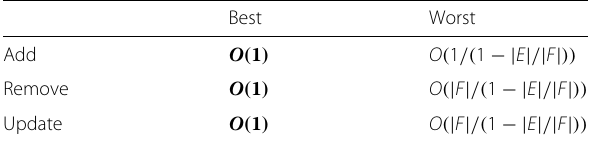
Table 2 Summary of algorithm operation complexity. Most common cases are marked in